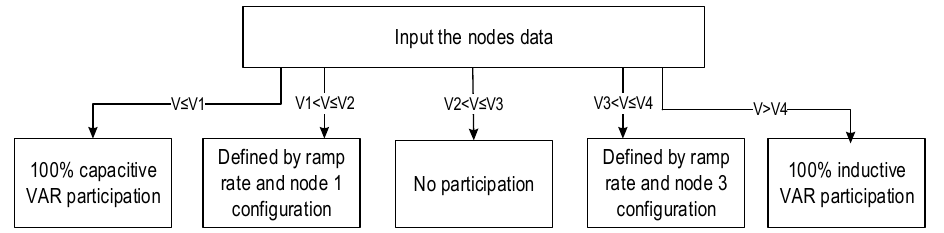
Figure 2. Desire VAR level determination algorithm.